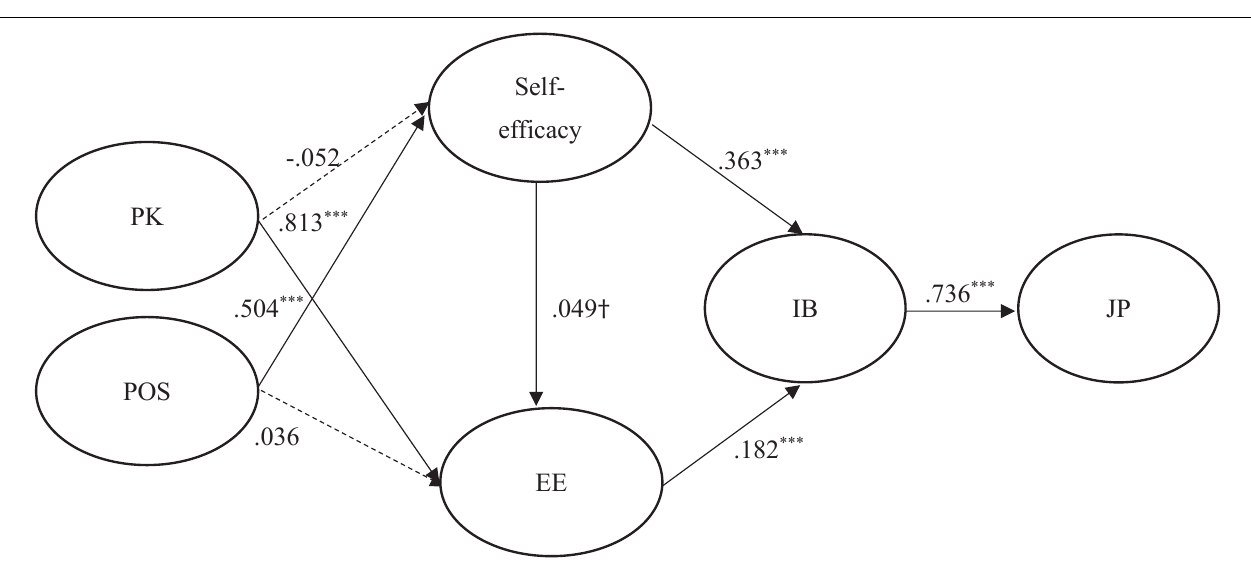
( Q 2 = 0.335), IB ( Q 2 = 0.352), and JP ( Q 2 = 0.303) were larger than zero, supporting the model has predictive relevance (Hair et al.,